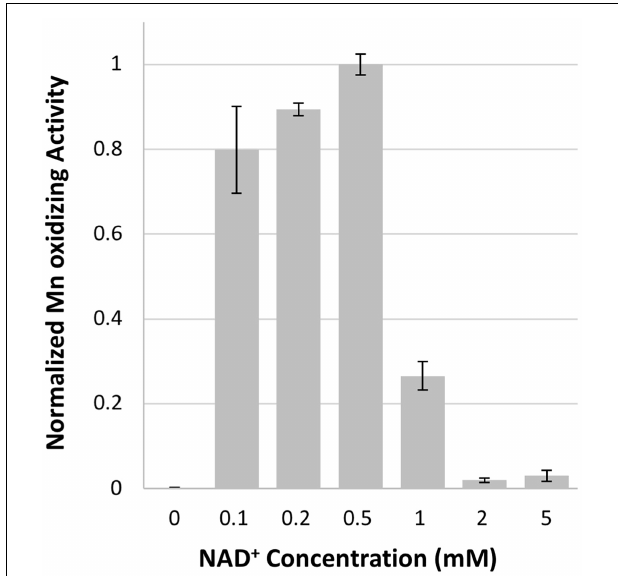
FIGURE 4 | NADH oxidation by 200 µ M Mn(III), E. coli Rosetta TM 2 “purified” protein (0.11 mg/ml), and NAC purified MopA-hp (0.19